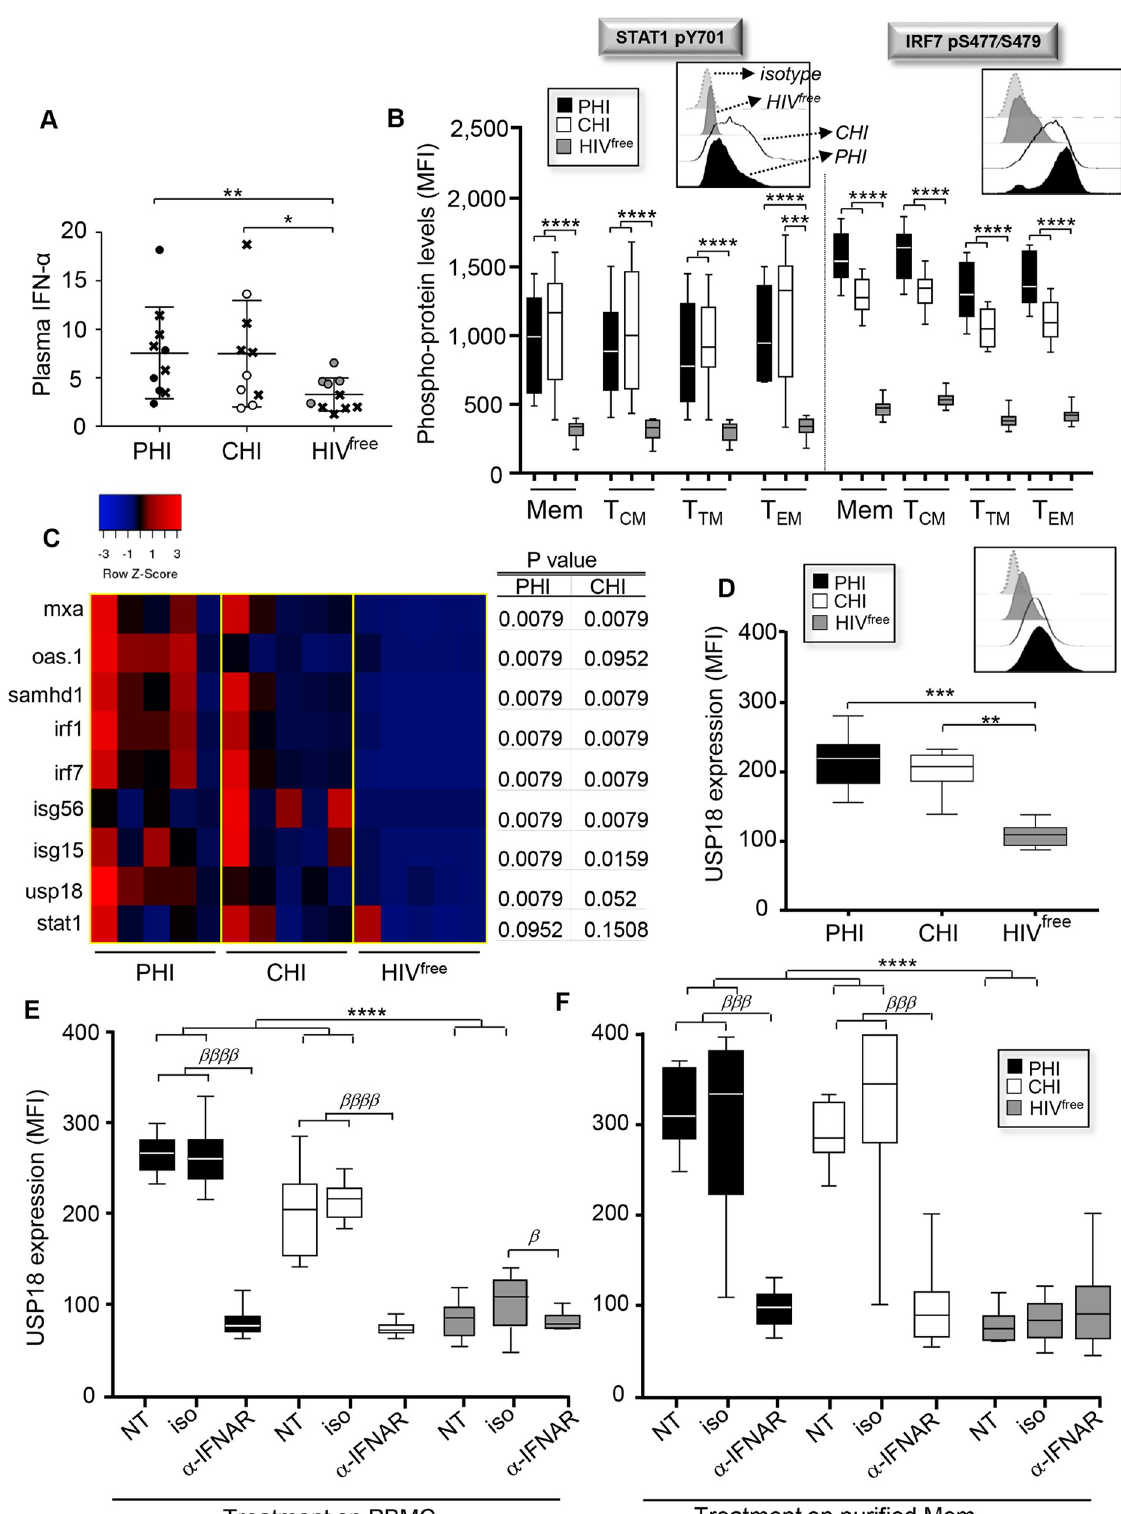
Fig 1. Mem from PHI and CHI display higher expression levels of USP18. ( A ) Plasma concentration of IFN- α in pg/mL for PHI, CHI and HIV free subjects. Crosses represent subjects used in C . (n = 10). ( B ) Levels of STAT1 pY701 and IRF7 pS477/479 on